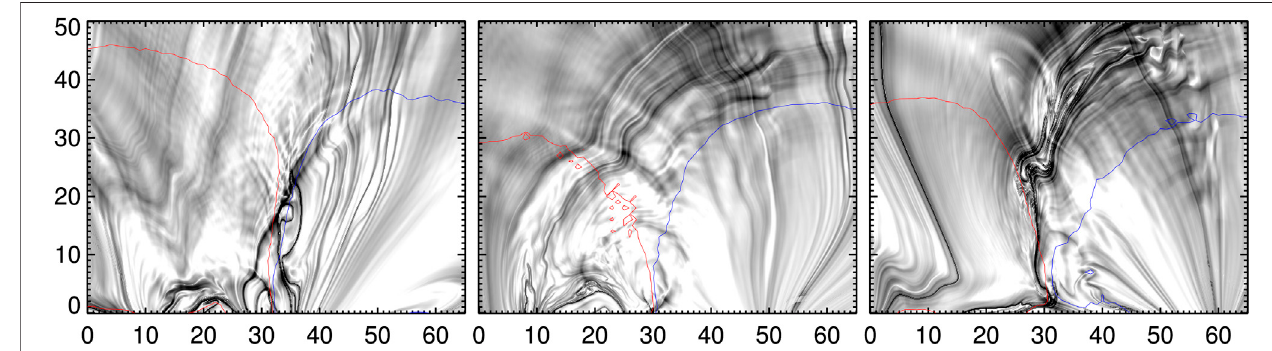
FIGURE 8 | Inverse maps of Log( Q ) in the vertical slice placed across the sigmoid in the AR 11429 as shown in Figure 4 . Contours of B z ( ± 80 G, red/blue curves) are over plotted. QSLs of large Q-values (black) are boundaries of magnetic domains enclosing the twisted-sheared core about the PIL.